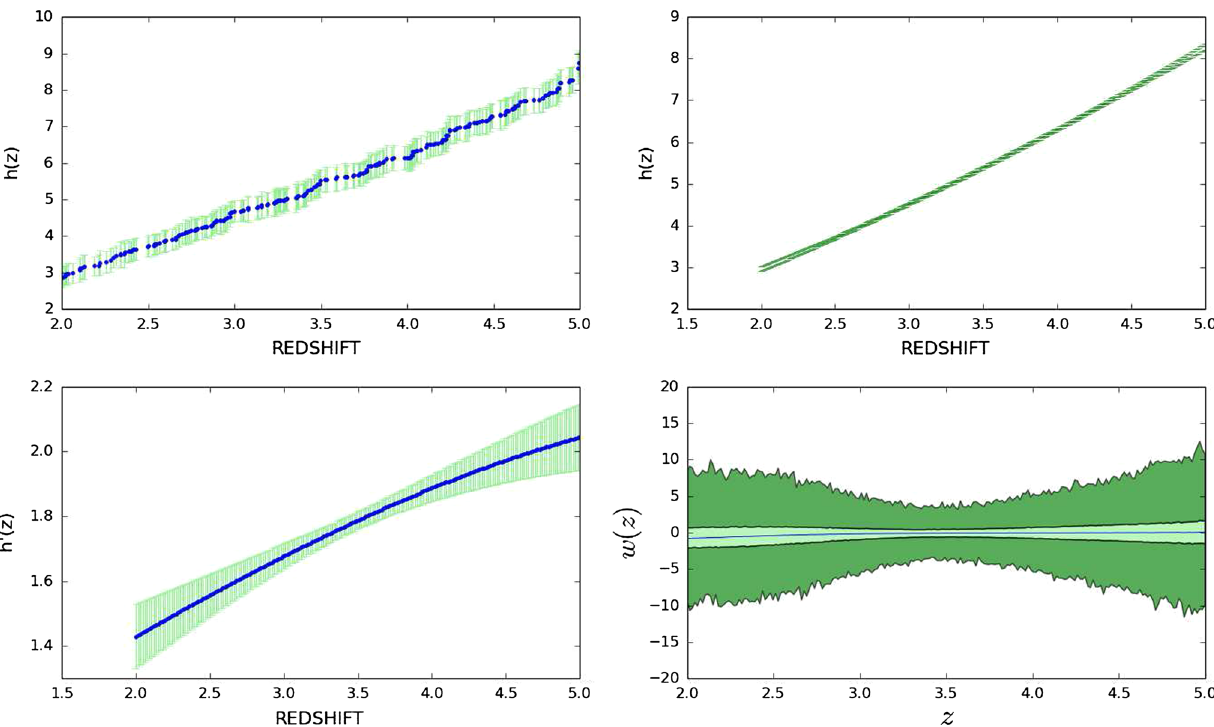
Fig. 5 In the top, we can see the simulated data using the Sandage–Loeb effect and the reconstruction of h ( z ) using the Gaussian process. In the bottom,weseethereconstructionofthefirstderivative h (cid:3) ( z ) andtheforecastedconstraintsforthecosmicequationofstatewith (cid:3) m 0 = 0 . 315 ± 0 . 007